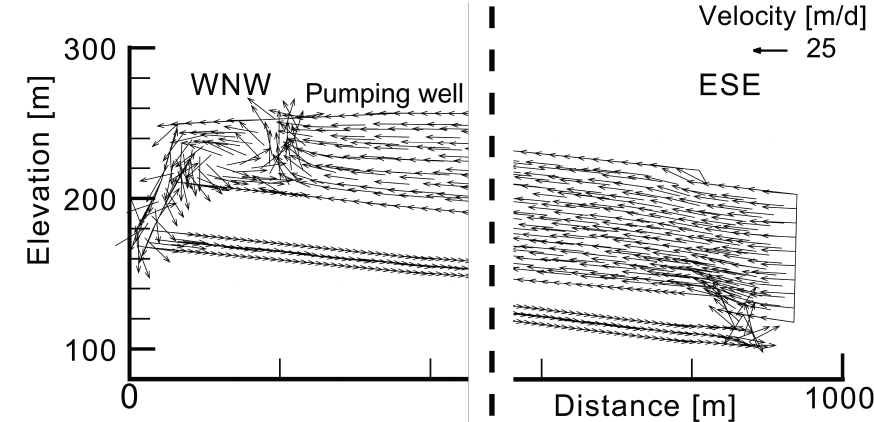
Figure 12. Flow vectors within the 2-D cross section for test case 1 after